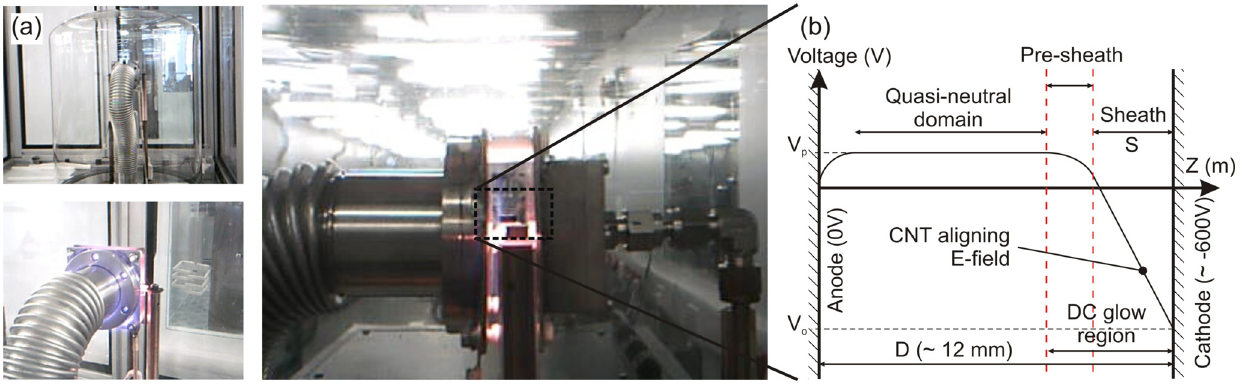
Figure 1. ( a ) Horizontal plasma enhanced chemical vapour deposition (PE-CVD) reactor; ( b ) Typical potential variation in a DC glow gas discharge plasma. (Typical process conditions: 50 W/700 V, 700 °C, 200:50 sccm, 3